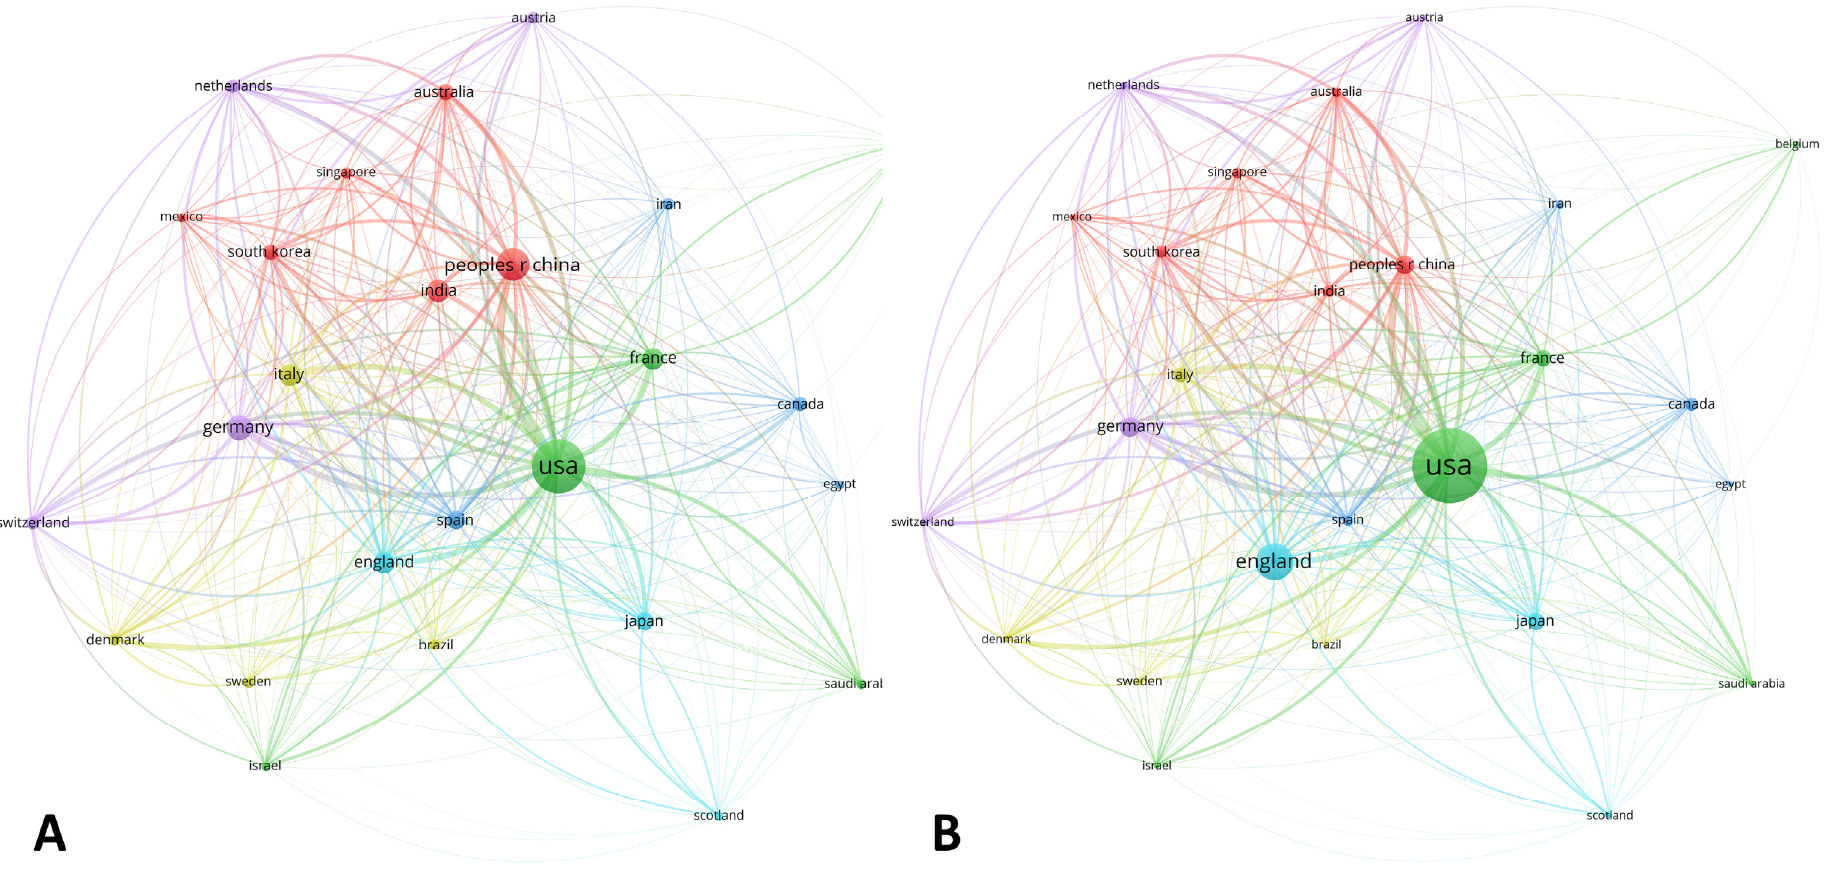
Figure 7. World map showing the structure of relations among countries as shown in the network visualization module of the VOSviewer software. ( A ) Map for the bibliometric coupling relation among countries according to the number of documents published for each country. ( B ) Map for the bibliometric coupling relation among countries according to the number of citations received for each